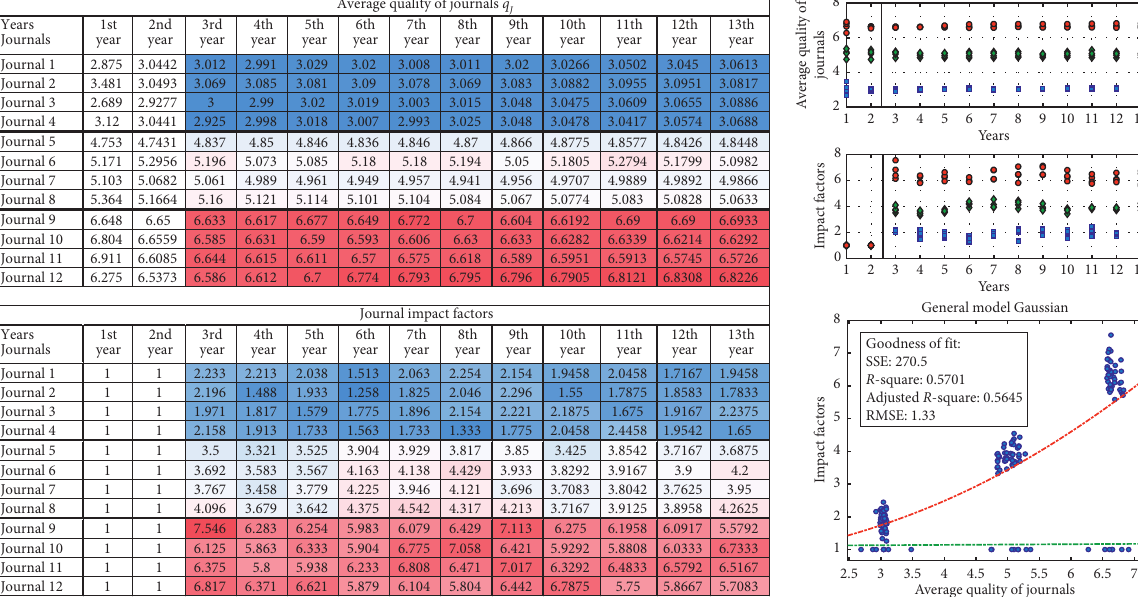
Figure 7: Comparison of average quality and impact factors of journals within 13 years. On the left, colors indicate groups of no significant pairwise differences, with greater results ( q J ≥ 6 and JIF ≥ 5) shown in dark red, the ones in between 4 . 8 ≤ q J < 6 and 3 ≤ JIF < 5 in light red or light blue, and worse results ( q J < 4 . 8 and JIF < 3) in dark blue. On the right are the illustrations of parallelcoords and Gaussian fitting, similar. In greater detail, the impact factor of the journal three different parameter settings (S1 (Figure 10(a)): � 10, β � 5, and c � 2; S2 (Figure 10(b)): with the number of references, N � 60 is much higher than α ( ( min ) ( min ) min ) � 40, β � 10, and c � 7; and S3 the impact factor of other two types of journals with N � 30 α ( ( baseline ) ( baseline ) baseline ) � 100, β � 20, and c � 10), it and N � 10. This result seems to show that the greater the (Figure 10(c)): α ( ( max ) ( max ) max ) average number of references ( N ) of a journal, the higher the can be seen that the overall trends of impact factors are